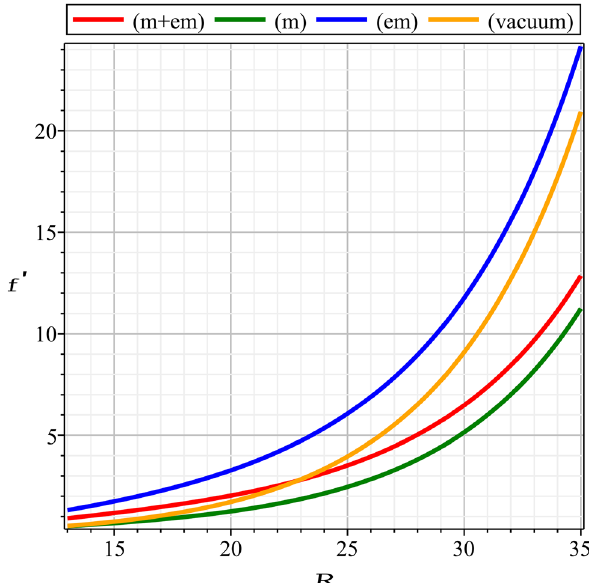
Fig. 7 This figure indicates the plot of f (cid:5) ( R ) for four options of inter- est (1– Pure electromagnetic case (blue color); 2 – Pure matter case (green color); 3 – Both electromagnetic and matter cases (red color); 4 – Vacuum case (orange color)) at curvature interval [ 13 , 35 ]